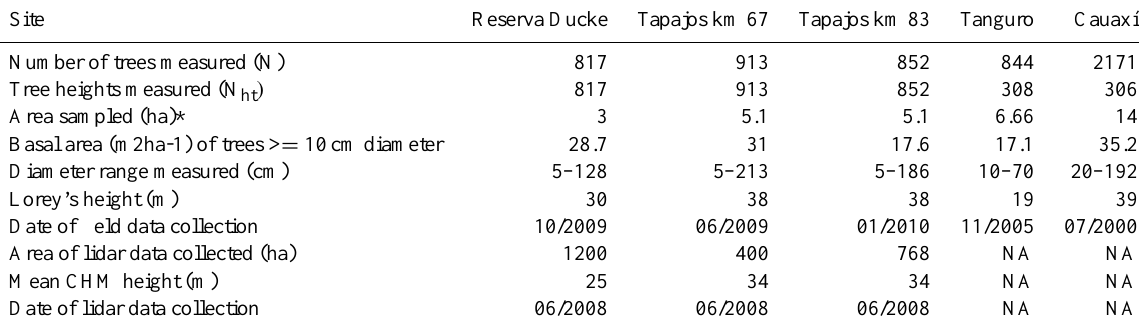
Table 3. Details of field and lidar data collection. Lidar data were collected for three of the five sites: Reserva Ducke, Tapajos km 67 and Tapajos km 83. Lorey’s height is the basal-area-weighted mean canopy height for all trees measured. (The nominal sample area of the field survey is reported at Tapajos and Reserva Ducke sites, as diameter-dependent line sampling was conducted.)